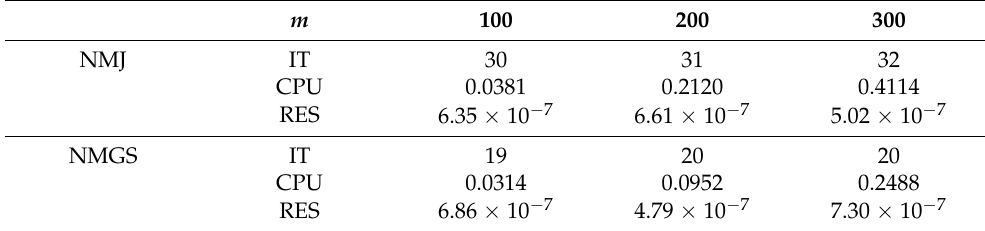
Table 1. Numerical results for Ω = 2 I .